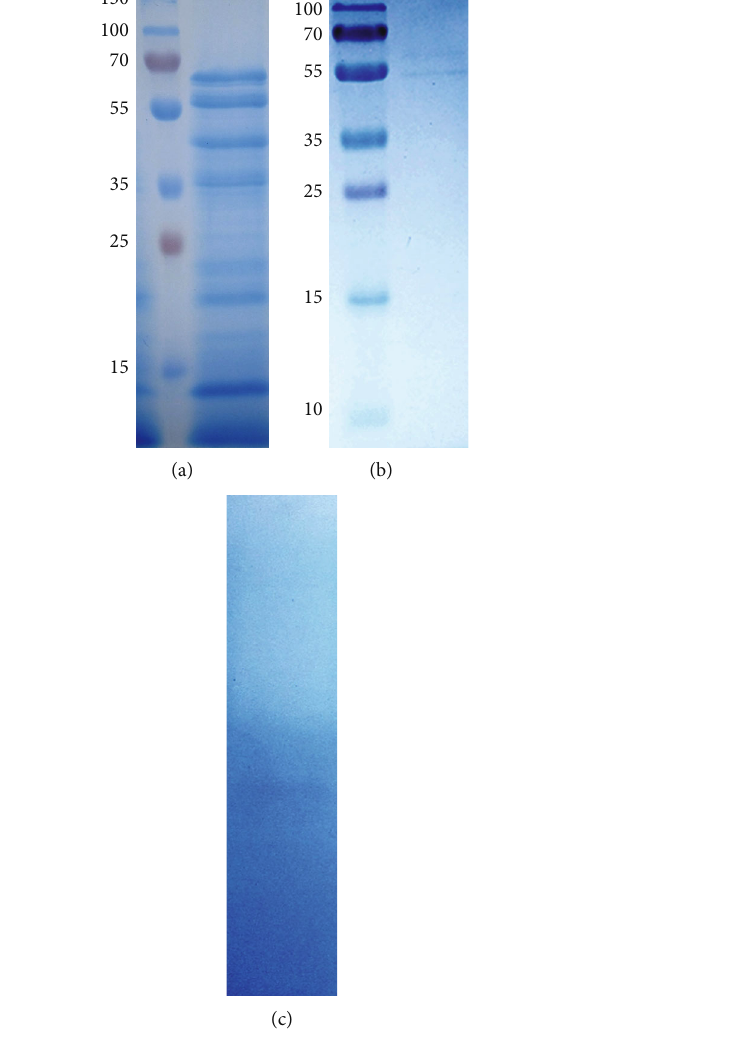
Figure 3: SDS-PAGE analysis of the crude extract from Solanum elaeagnifolium fruits (a), and partially puri fi ed proteases from the crude extract (b), with its proteolytic zymogram (c). Lane 1=molecular weight marker, lane 2=crude extract, lane 3=molecular weight marker, lane 4=fraction recover sulfate ammonium precipitation (50%) and gel fi ltration on Sephadex